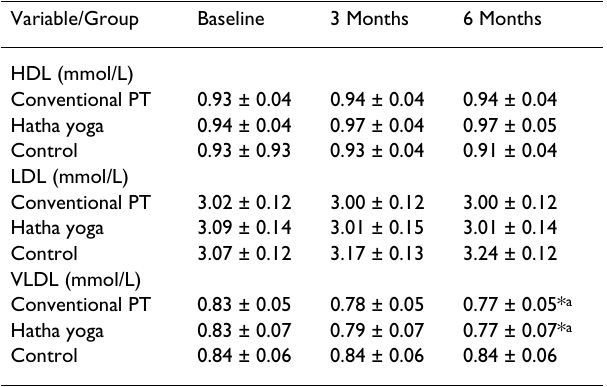
Table 3: Comparison of HDL, LDL and VLDL among conventional PT exercise, Hathayoga exercise and control type 2 diabetic patients over a 6-month period Variable/Group